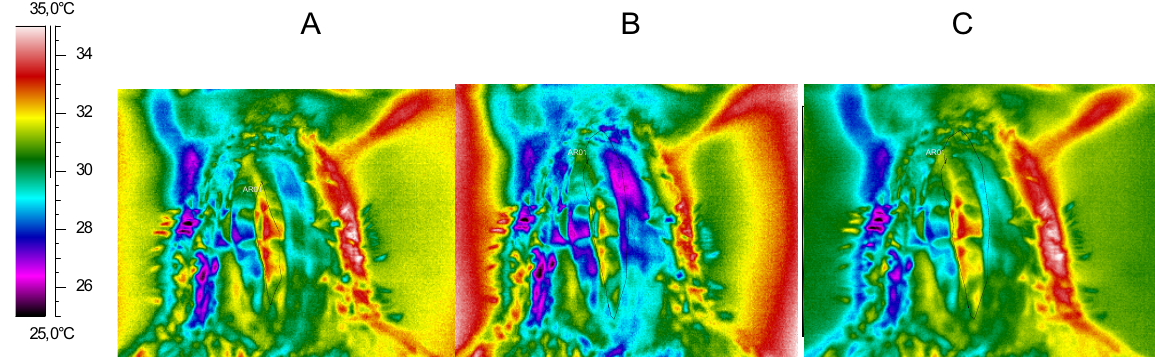
FIGURE 6 – Thermograms in group III: A – before ischemia; B – after ischemia; C – after